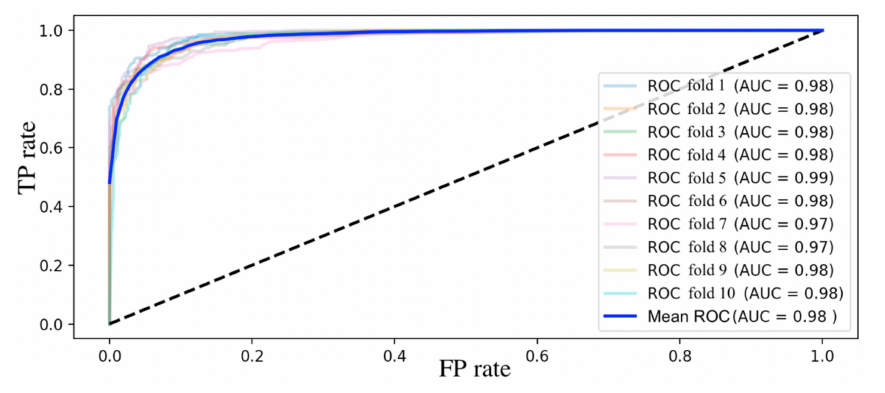
Figure 9. 10-fold cross validation of the RF